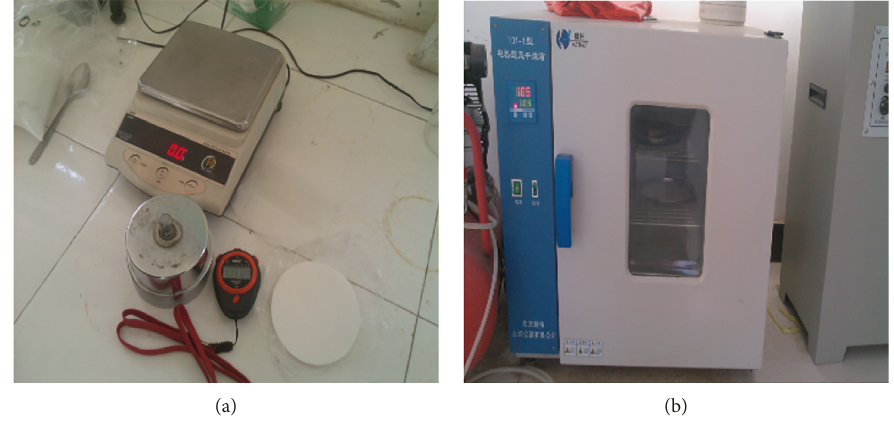
Figure 2: Water-retention test instrument.